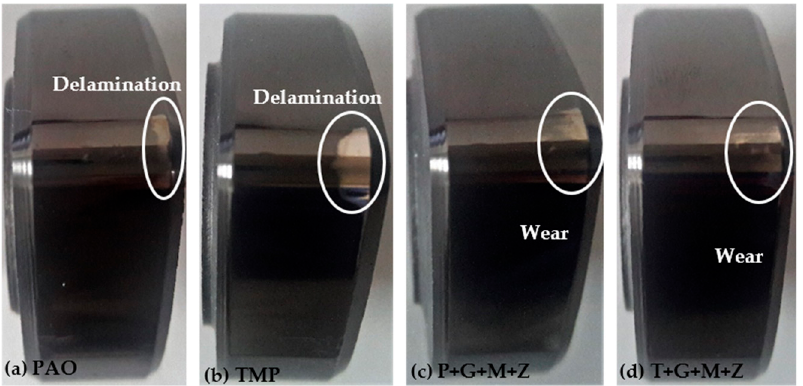
Figure 9. Optical images of a-C:H-coated camlobes after cylinder head testing in combination with a-C:H-coated tappets under various conditions with TMP-based and PAO-based lubricants.